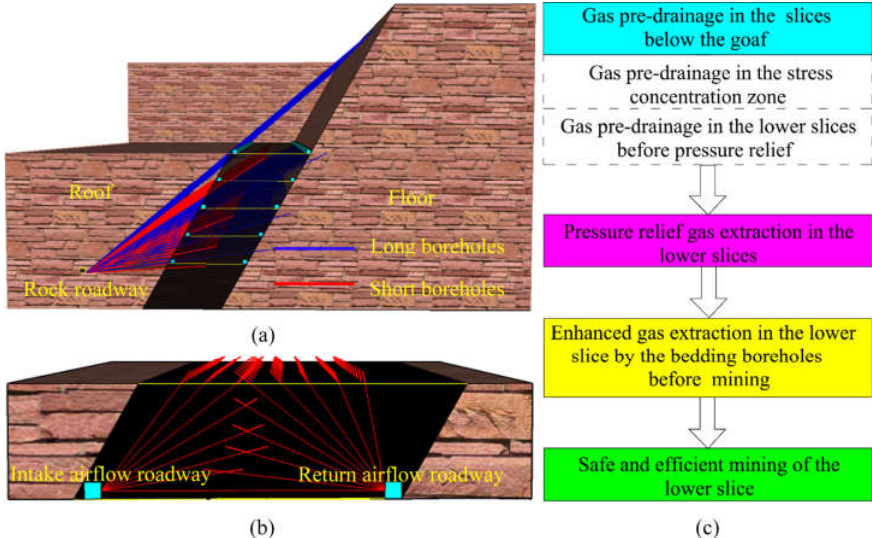
Figure 14. Schematic view of the gas extraction in the steep and extra-thick coal seam: ( a ) crossing boreholes from the rock roadway in the roof; ( b ) bedding boreholes from the roadway of the working face; and ( c ) the gas extraction flow chart.